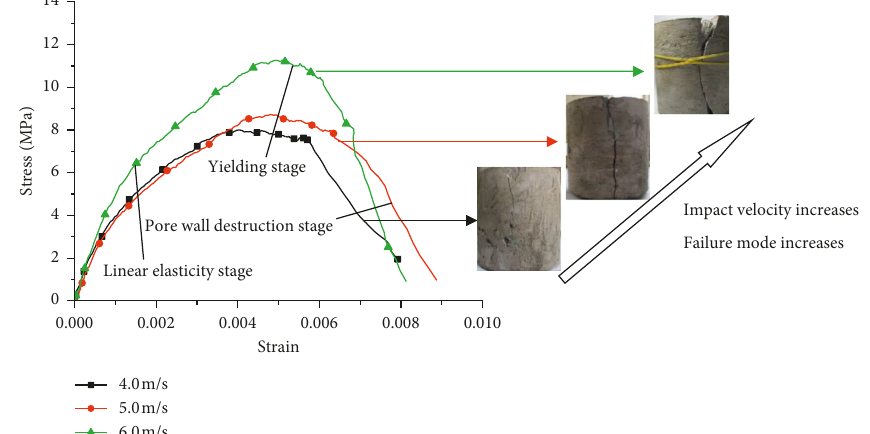
Figure 9: Foam concrete with sand stress-strain curve at 1,200kg/m 3 .